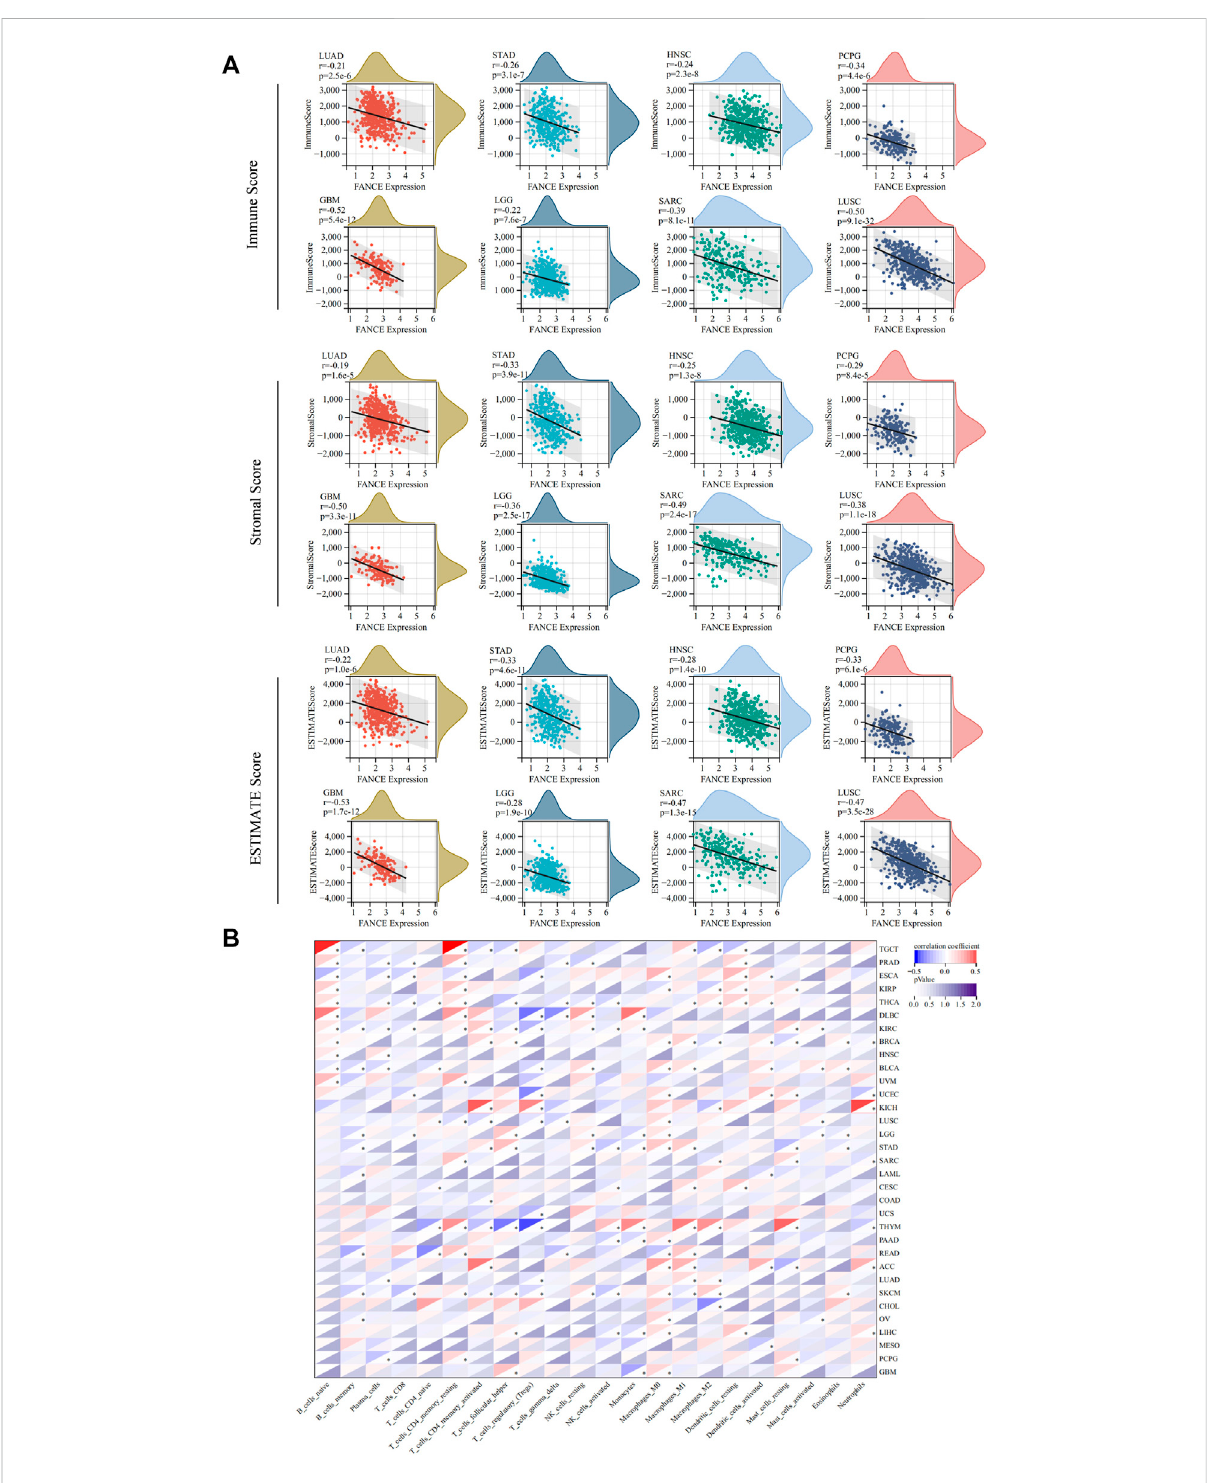
FIGURE 9 Tumor microenvironment (TME) and tumor-in fi ltrating immune cells (TIICs) analysis with FANCE expression in pan-cancer. (A) Correlation between FANCE expression and the immune Score, stromal Score, and ESTIMATE score in TME. The top eight cancers with the most signi fi cant association were displayed, including LUAD, STAD, HNSC, PCPG, GBM, LGG, SARC, and LUSC. (B) Correlation between FANCE expression and the proportion of 22 types of TIICs. * p < .05; ** p < .01; and *** p <